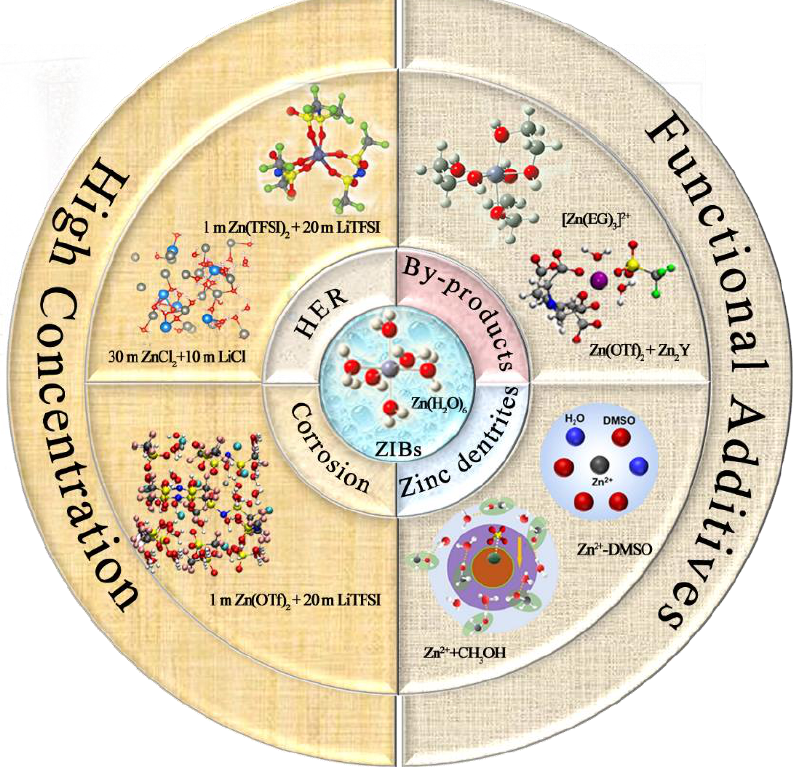
Figure 2. Schematic illustration of solvation structure regulation strategies.